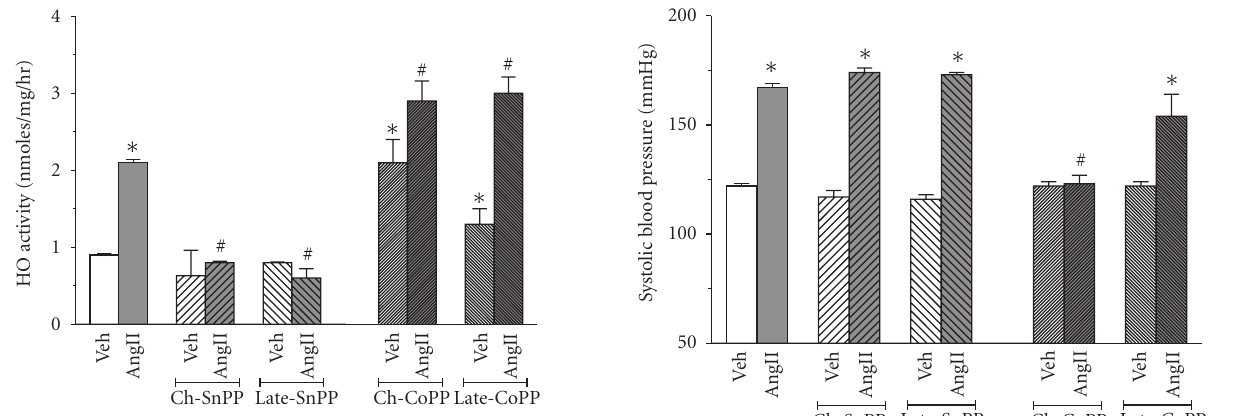
Figure 2: E ff ect of SP-Ang II and HO modulation on the SBP in the following groups Vehicle- (Veh-) treated ( n = 6), SP-AngII-treated ( n = 6), chronic-SnPP- (Ch-SnPP-) treated ( n = 6), SP-AngII/Ch- SnPP-treated ( n = 6), late-SnPP-treated ( n = 5), SP-AngII/late- SnPP-treated ( n = 5), chronic-CoPP- (Ch-CoPP-) treated ( n = 6), SP-AngII/Ch-CoPP–treated ( n = 6), Late CoPP-treated ( n = 5), SP-AngII/late-CoPP-treated ( n = 6) rats. ∗ P < 0 . 05 versus. control, # P < 0 . 05 versus. SP-AngII.